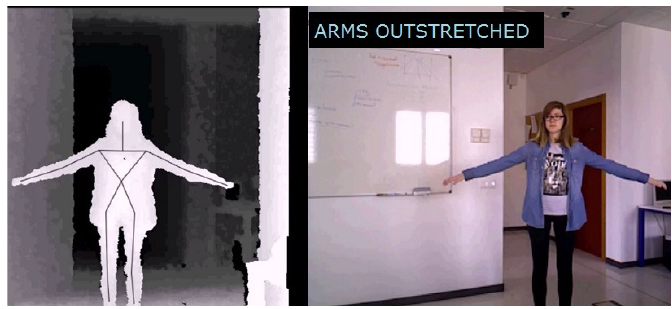
Figure A3. Arm outstretched